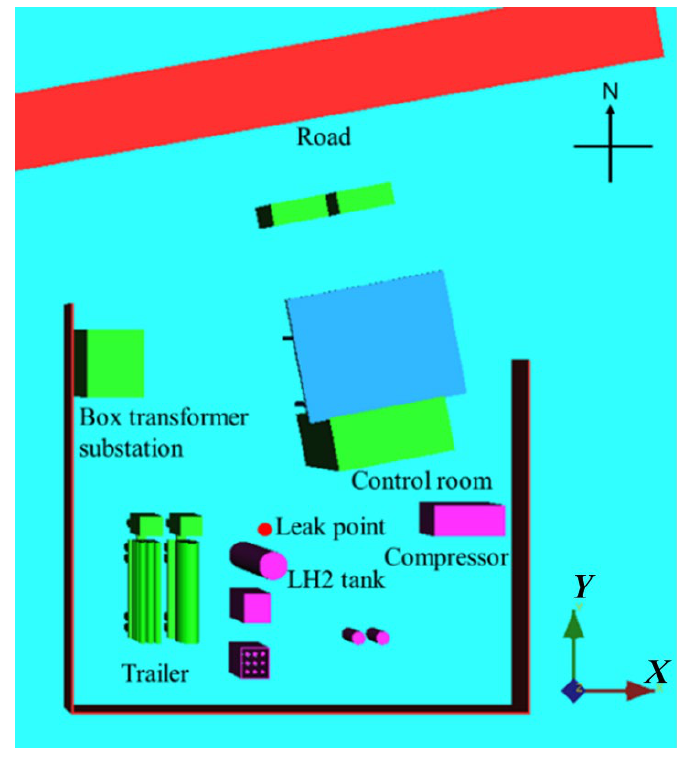
Figure 1. Schematic configuration of th e